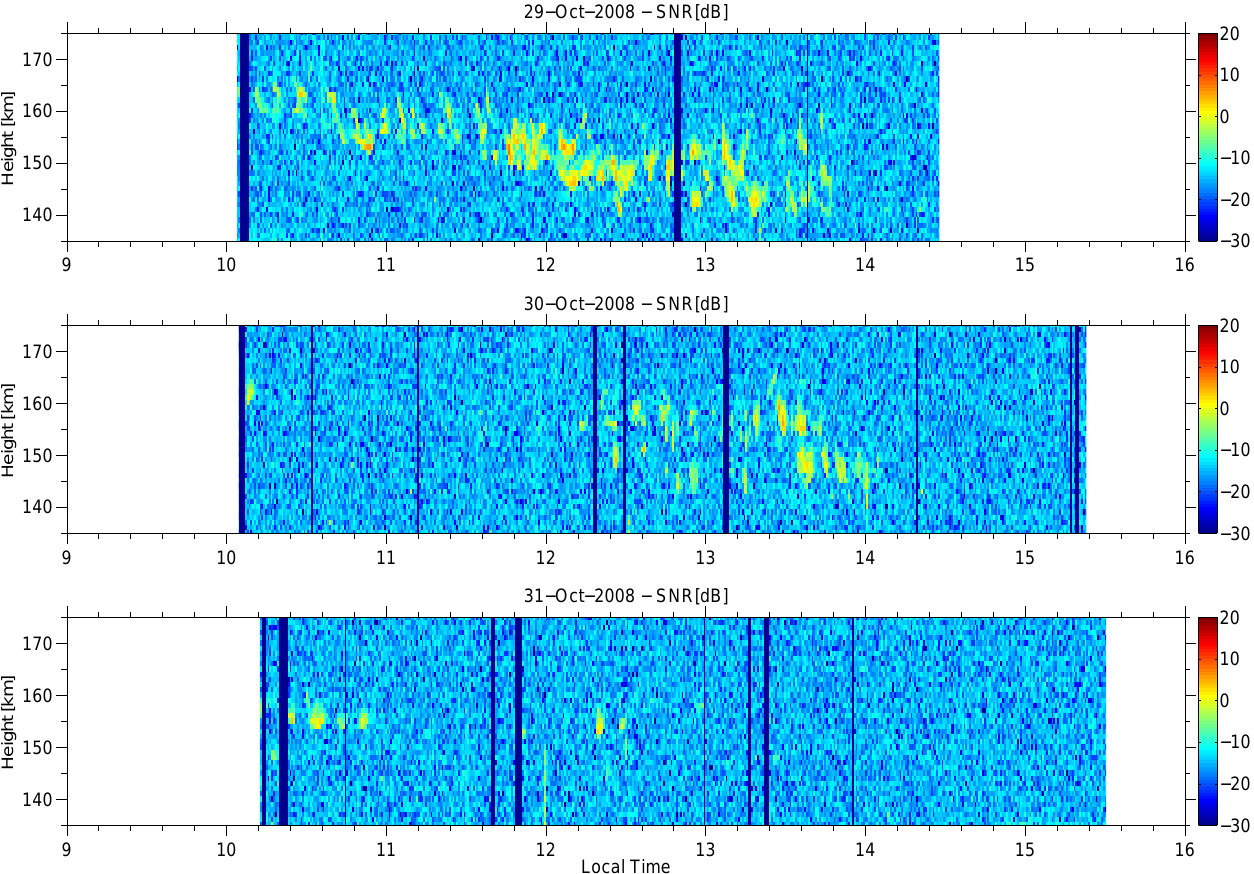
Fig. 5. Range-Time-Intensity (RTI) maps of upper E-region observations made by the S˜ao Lu´ıs radar in Brazil on three consecutive days during 29–31 October